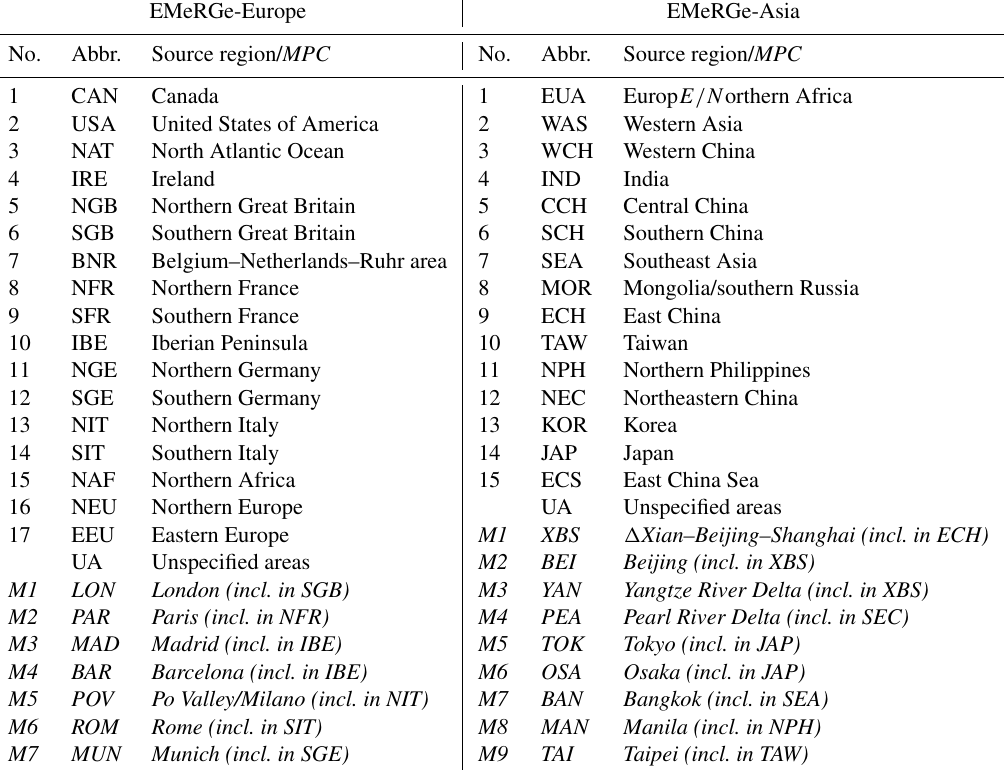
Table 4. Source regions and MPCs (italic) selected for EMeRGe-Europe and EMeRGe-Asia. Coordinates are listed in Table S3, Sect. S6.